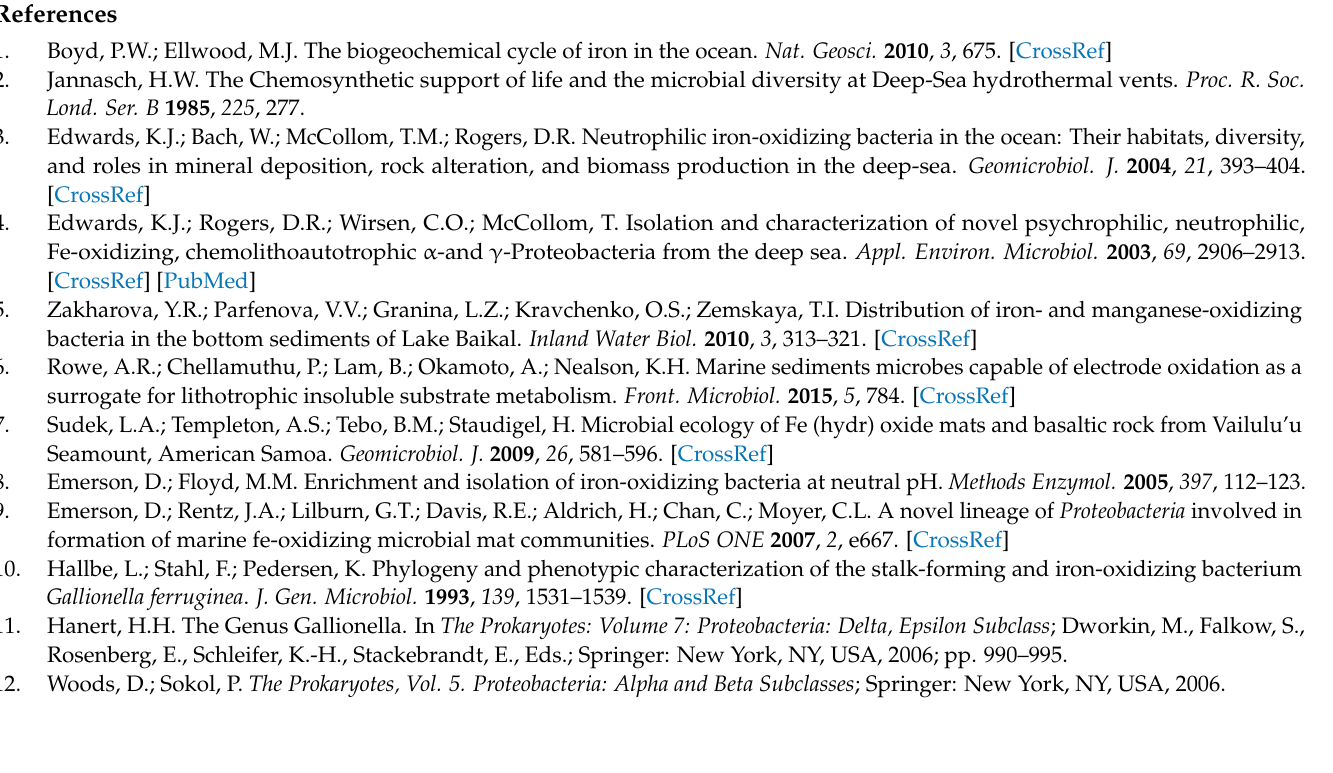
proteins; Figure S6: Sequence alignment of CumA proteins in the isolates and CumA identified from Pseudomonas putida GB-1; Figure S7: Sequence alignment of Nar I proteins in the isolates and Nar I (respiratory nitrate reductase 1 gamma chain) identified from E. coli ; Table S1: Average